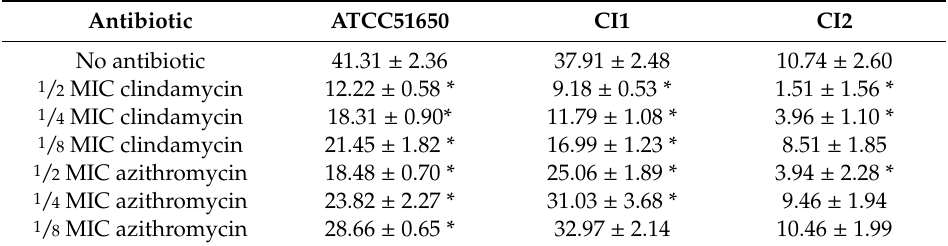
Figure 2. Protein content of S. aureus exoproteins after sub-inhibitory clindamycin and azithromycin treatment. ( a ) Protein content measured by NanoOrange ( μ g/mL) or ( b ) gel electrophoresis of ATCC 51650, CI1 and CI2 24-h planktonic cultures in the absence (no antibiotic, grey bar) or presence of ½, ¼ or ⅛ MIC clindamycin (blue bars) or azithromycin (green bars). n = 3. * p < 0.05, ** p < 0.01, one-way ANOVA followed LSD post hoc comparison. Table 2. Gray scale analysis of the sodium dodecyl sulphate polyacrylamide gel electrophoresis (SDS-PAGE) with Image J. (compared with no antibiotic treatment, * p < 0.05, one-way analysis of variance (ANOVA) followed by Least Significant Di ff erence (LSD) post hoc comparison.). CI = clinical isolate, MIC = minimum inhibitory concentration.